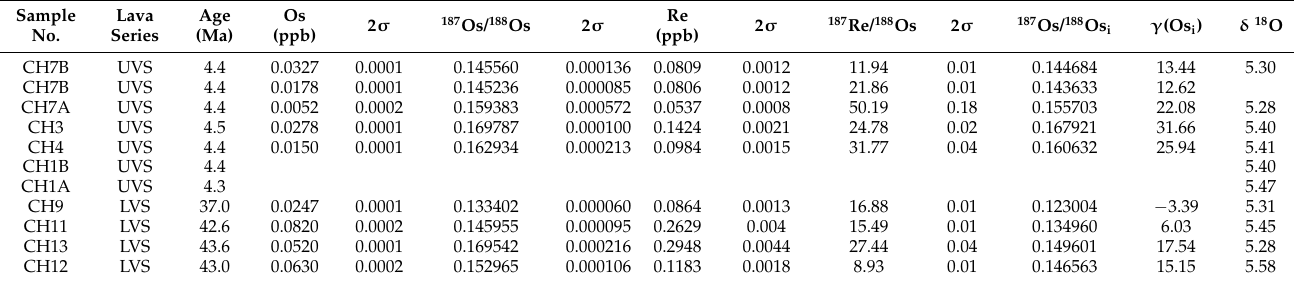
Table 3. Os, Re and O isotopes of Christmas Island volcanic